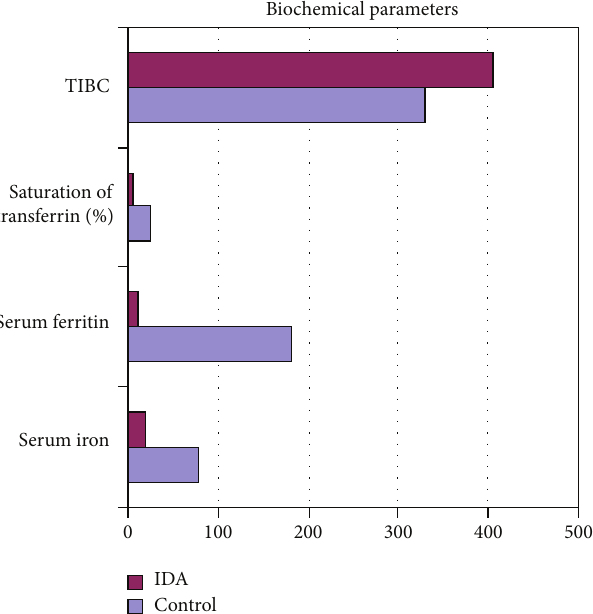
Figure 3: Showing biochemical parameters in control and IDA.